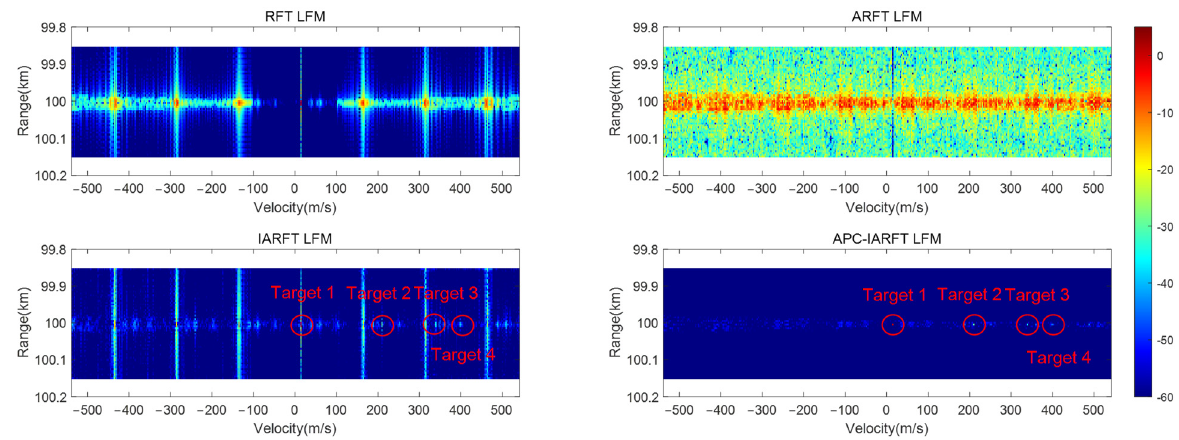
Figure 9. Plan output of four methods in Scenario 2.